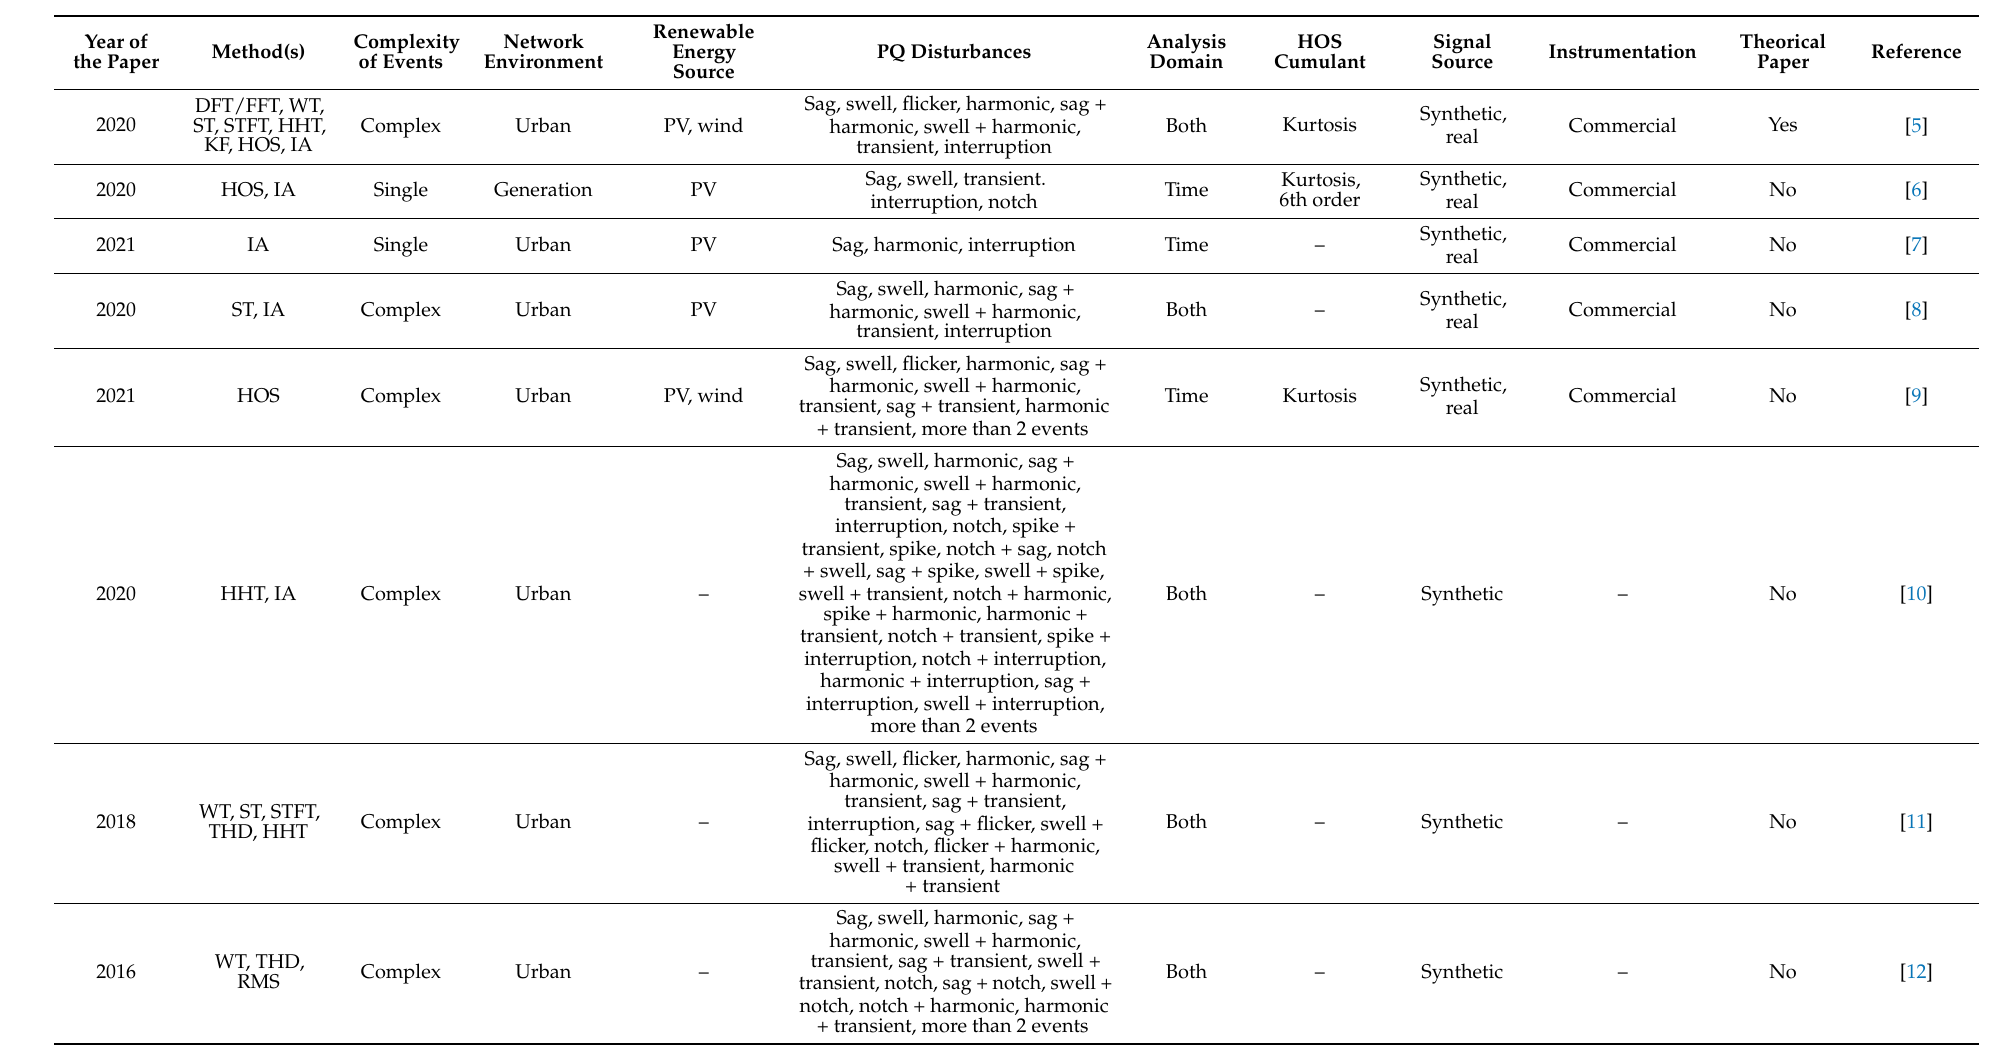
Table 2. Selected papers described by the possible values of the analysis criteria defined to characterize the documents in Table